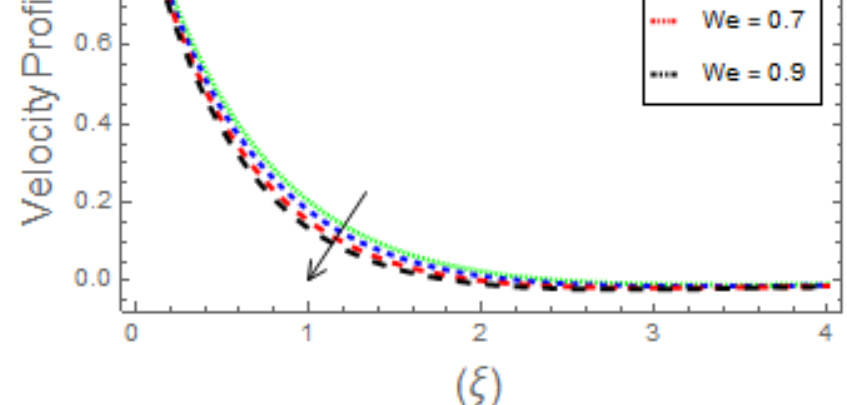
Figure 6. Variation in f (cid:48) ( ξ ) due to We .